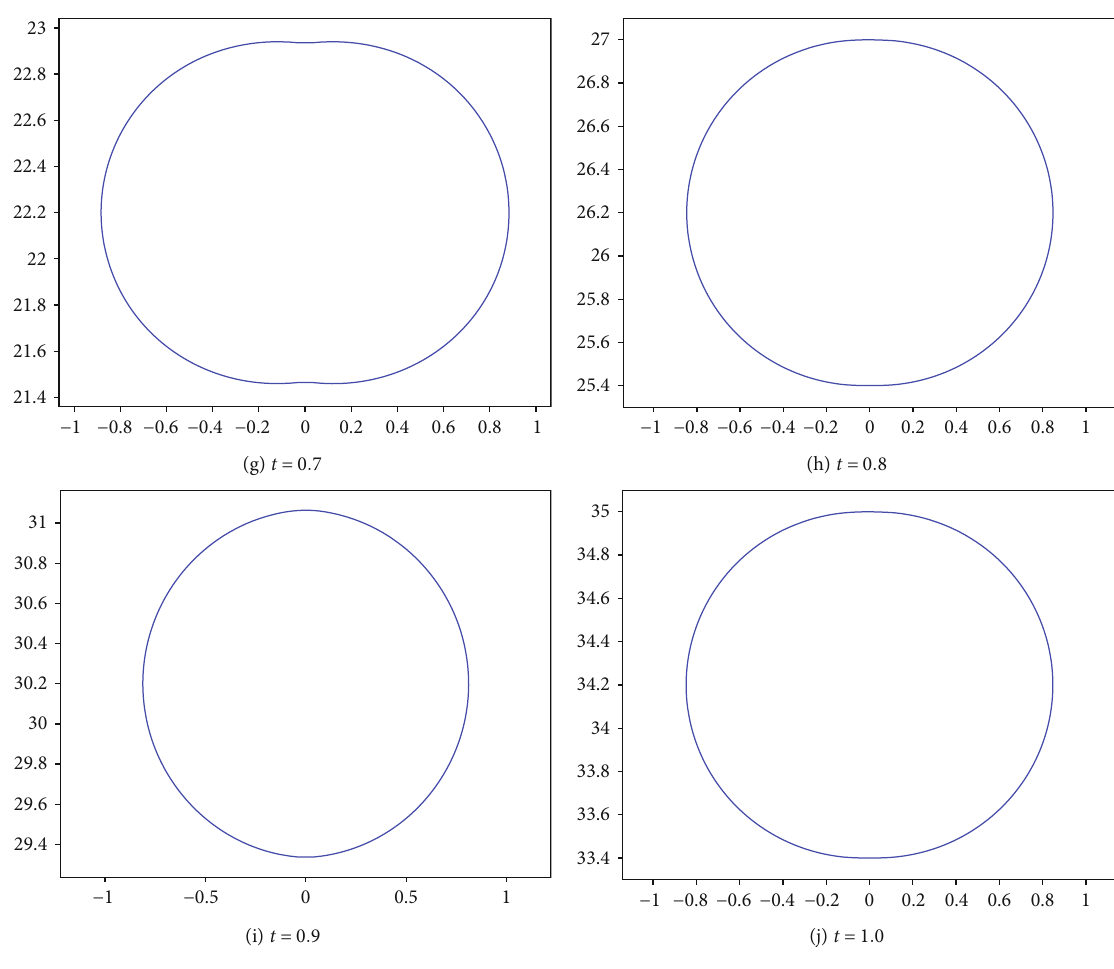
Figure 5: Coalescence of two 2D bubbles in horizontal